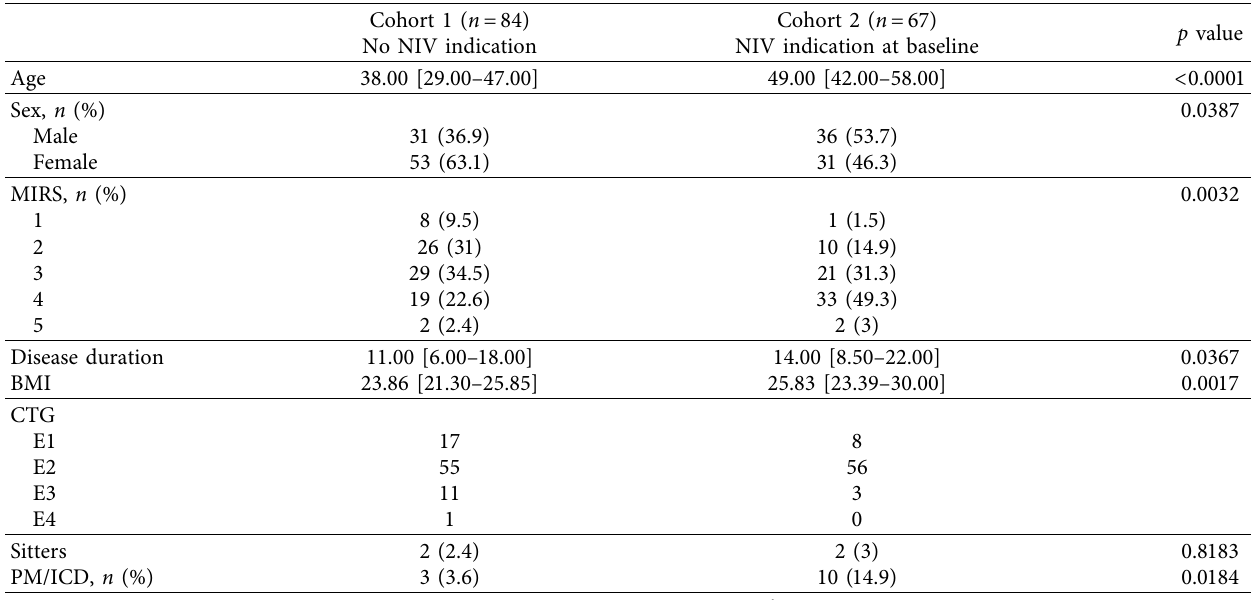
Table 3: Clinical and demographic comparison between cohorts according to NIV